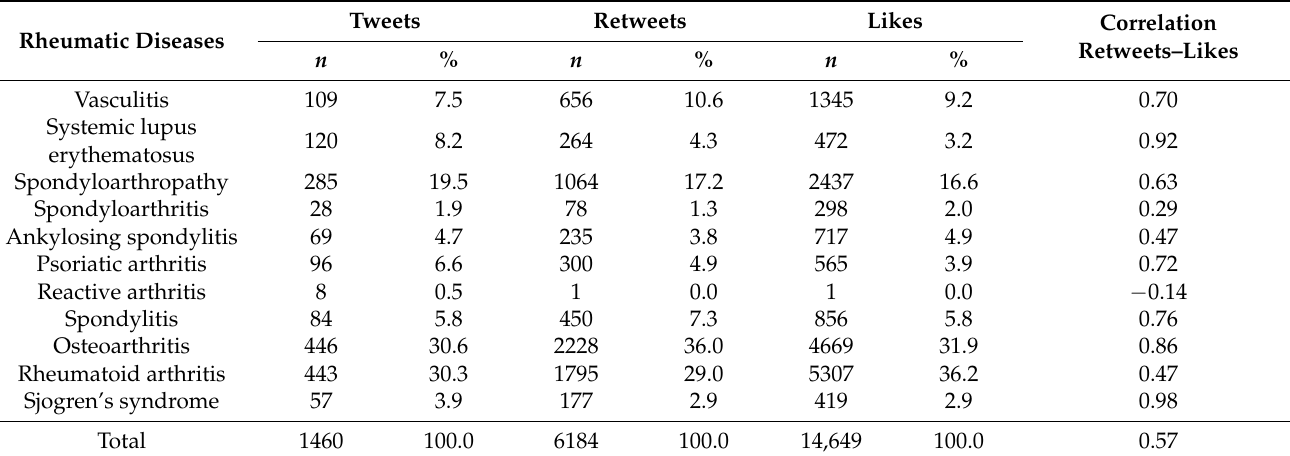
Table 1. Number of tweets, retweets, and likes related to the rheumatic diseases analyzed.